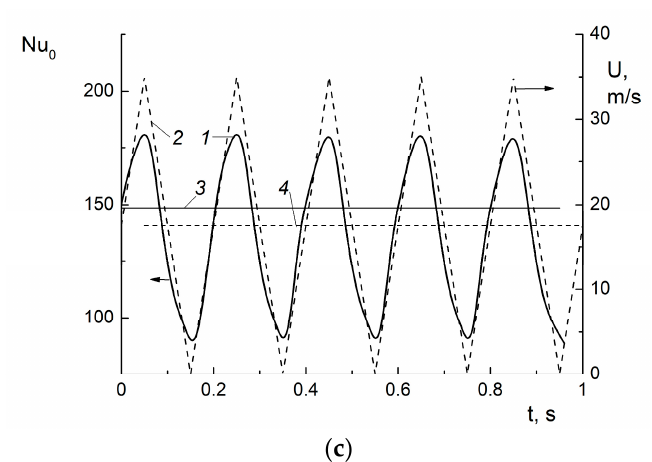
Figure 5. Distributions of instantaneous Nusselt number at the stagnation point Nu 0 ( 1 ) and mean axial velocity U ( 2 ) in the pulsed impinging jet for rectangular ( а ), sinusoidal ( b ) and triangular ( c ) signal forms. Re = 23000, H / D = 2, T W = 373 K, T 1 = 293 K, f = 5 Hz, St = 0.006. 1 —instantaneous Nusselt number at the stagnation point, 2 —mean axial velocity, 3 —Nusselt number at the stagnation point in the steady-state impinging jet, 4 —mean-mass velocity magnitude.